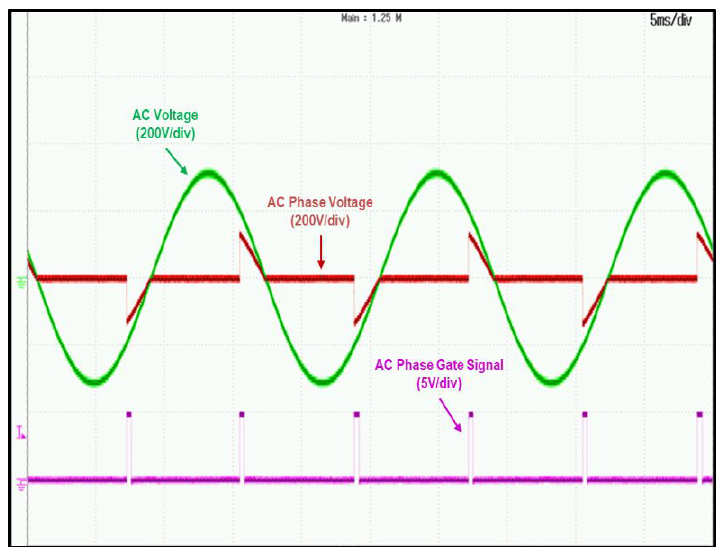
Figure 12. The waveforms of AC voltage and AC phase control voltage.